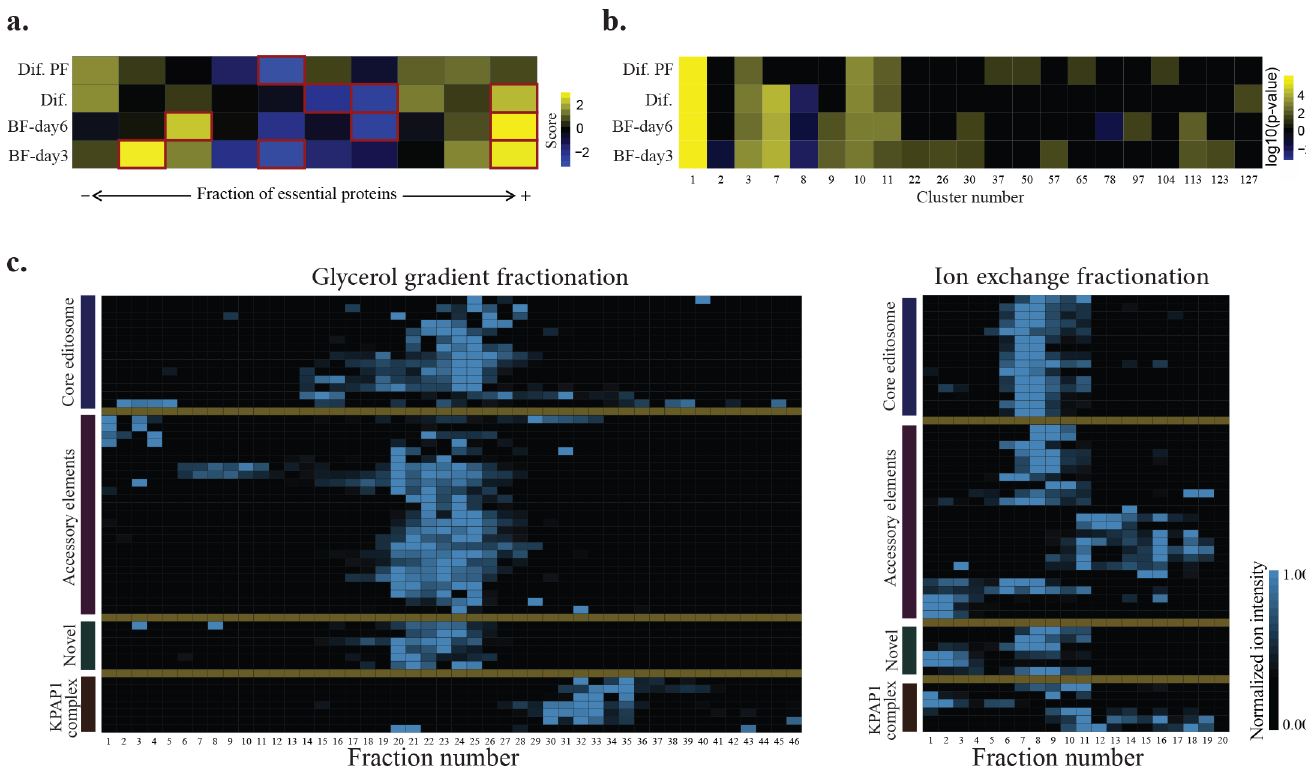
Fig 7. Evaluation of predicted complexes based on TbCF HC net. a) The 128 predicted complexes were classified to ten uniformly spaced bins based on the fraction of essential proteins present in each complex. The number of complexes present in each bin was compared to the expected background distribution using MATLAB kernel smoothing function. The expected background distribution was estimated by applying the same clustering analysis (i.e., ClusterOne algorithm) to 10,000 random networks from TbCF net, generated by shuffling the protein labels, while preserving structural properties. Figure represents the calculated kernel score for each bin, with blue and yellow colors indicating under-representation and over-representation, respectively. Significantly enriched or depleted bins are shown by red borders. As shown, we observe over-representation of TbCF HC net-derived complexes with enriched or depleted fraction of essential genes (corresponding to right and left bins, respectively). However, TbCF HC net-derived complexes with random distribution of essential genes (corresponding to the bins in the middle) were under-represented. The list of essential genes in 4 different life stages of T . brucei was extracted from [60]. (Dif. PF: differentiated procyclic cells; Dif.: Differentiating cells from bloodstream to procyclic; BF-day6: Representing bloodstream stumpy form; BF-day3: Representing bloodstream short slender form). b) The 128 predicted complexes were examined for possible enrichment of essential proteins in different life stages and during the differentiation process from bloodstream to the procyclic form (see above for abbreviations). The enrichment analysis was performed using Fisher ’ s exact test. At the p-value cut-off threshold of 0.05, the yellow color indicates a significant over-expression and the blue color represents a significant under-representation of essential proteins in a complex. It should be noted that most of predicted complexes had small sizes (median of four subunits per complex). Therefore, the statistical test did not have enough power to detect significant over-/under- representations of essential genes in these small complexes. Correspondence of previously known protein complexes to the reported complexes in this figure: cytoplasmic ribosomal complex (Complex 1), proteasome (Complex 3), and T-complex (Complexes 10 and 11), intraflagellar proteins (Complex 7), mitochondrial ribosome (Complex 2 and 8). c) GG and IEX fractionation patterns for the proteins known/predicted to be involved in the RNA editing and KPAP1 complex. Proteins are categorized in four groups of core editosome, accessory elements, novel proteins, and KPAP1 complex. The associated protein names are included in S14